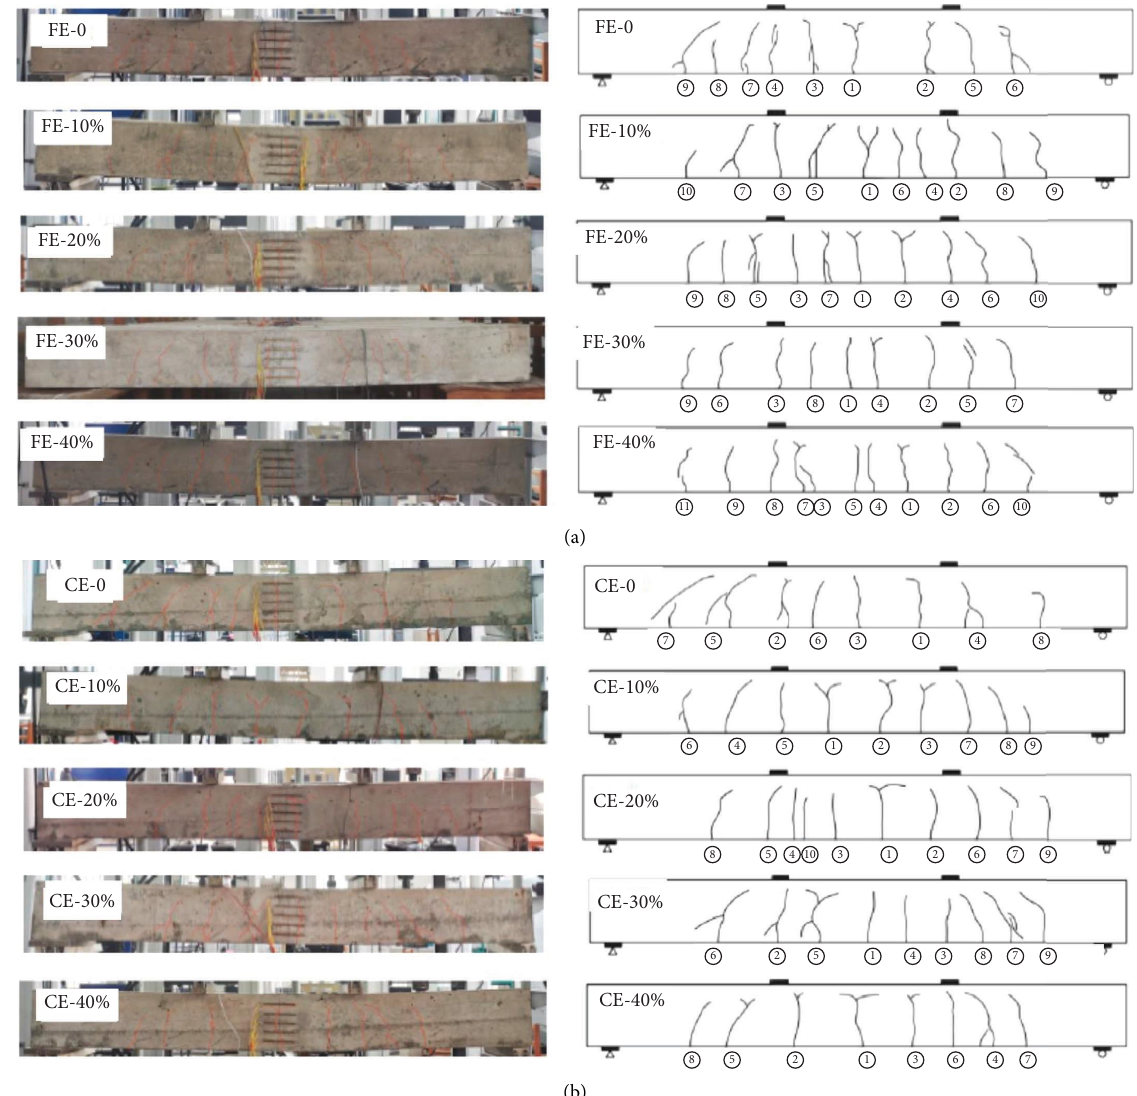
Figure 4: Bending failure mode and crack distribution map of test beam under water and chloride environment. (a) Fresh water en- vironment and (b) chloride Table 3: Test values of cracking load and ultimate load of test beams in three environments. Graphite tailings sand replacement rate (%)